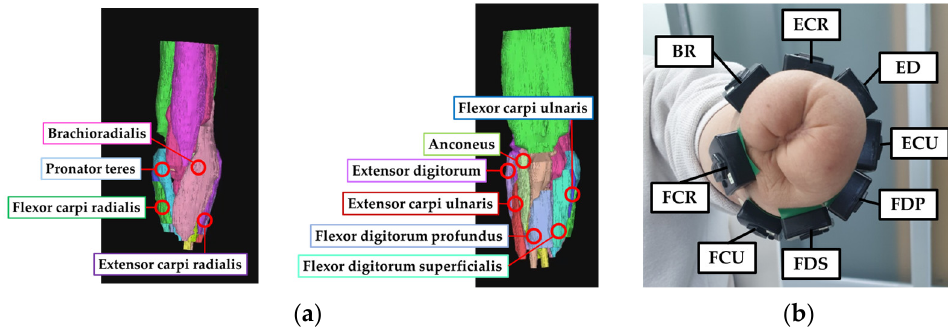
Figure 1. Experimental equipment: ( a ) multichannel sEMG system, ( b ) hand dynamometers.